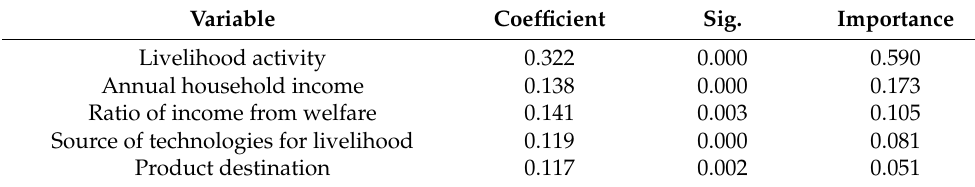
Table 4. Model parameters to predict impacts on spiritual well-being. Variable